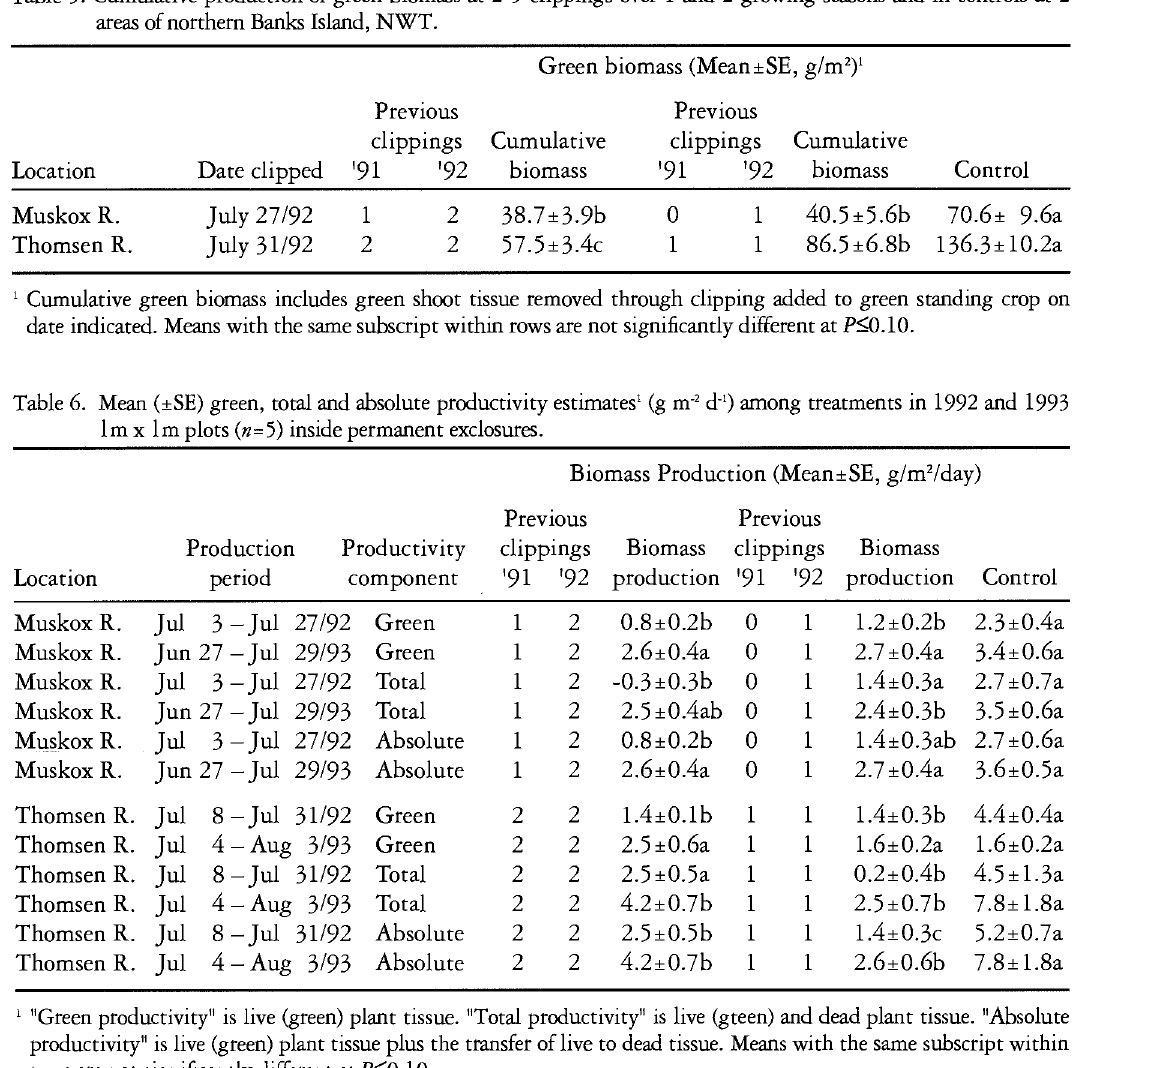
Table 5. Cumulative production of green biomass at 2-5 clippings over 1 and 2 growing seasons and in controls at 2 areas of northern Banks Island, NWT.